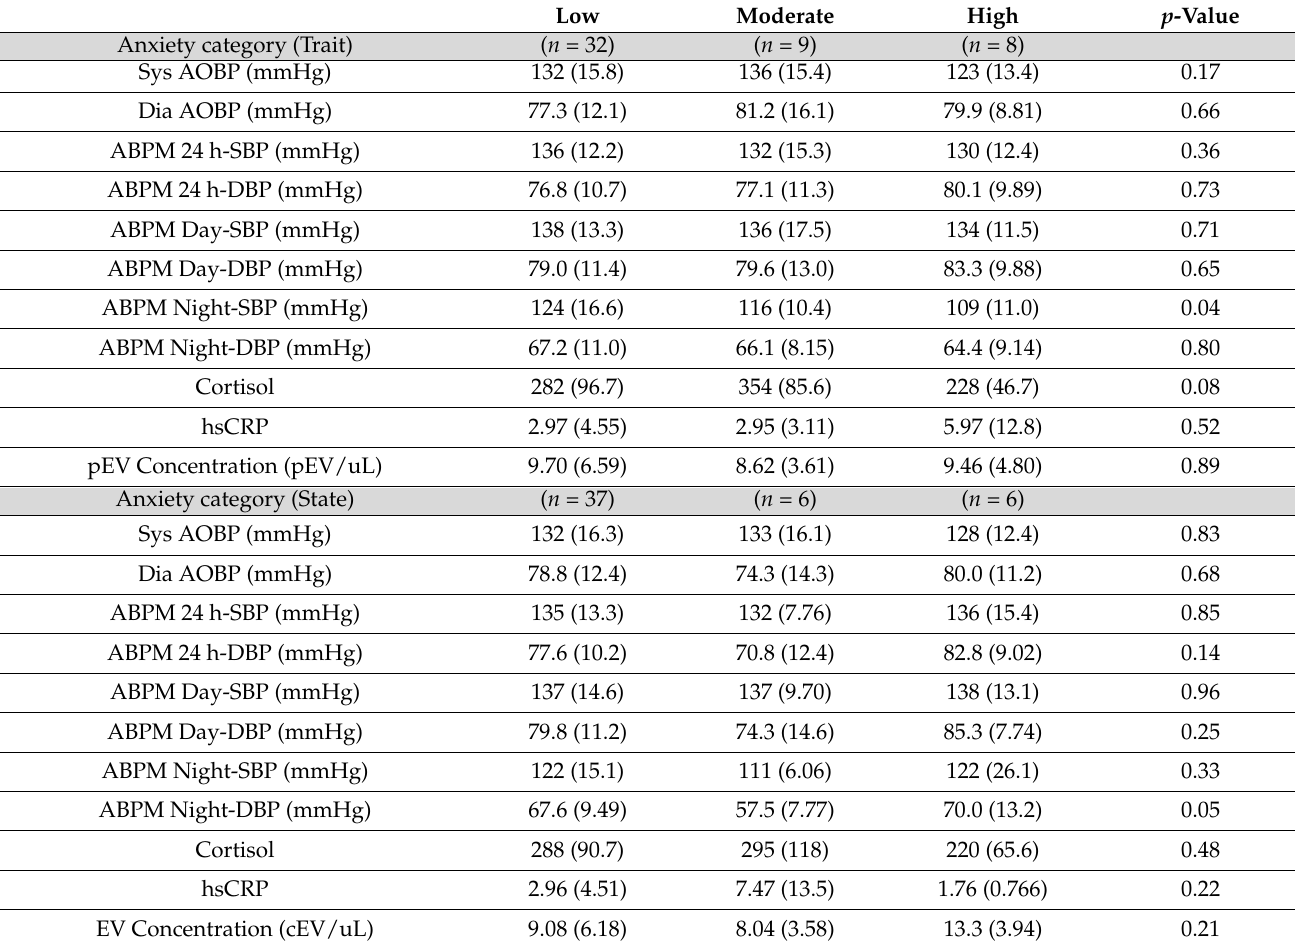
Table 4. Summary of the platelet derived extracellular vesicles and blood pressure measurements in patients with and categories of